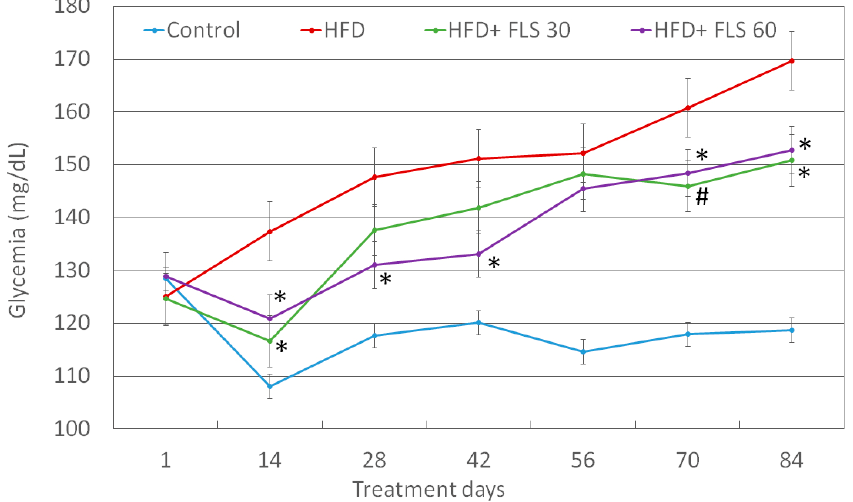
Figure 5. Average fasting glucose measured in the blood of the mice throughout the whole duration of the experiment. Error bars represent the standard error of the mean. *, p < 0.05; #, p < 0.01 com- pared to the HFD